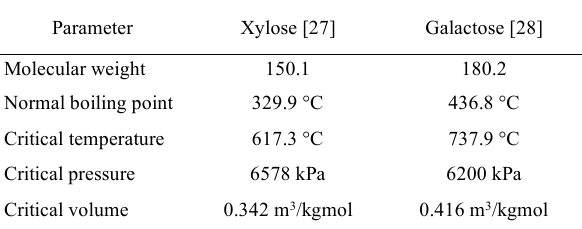
Table 1. Hypothetical component parameters